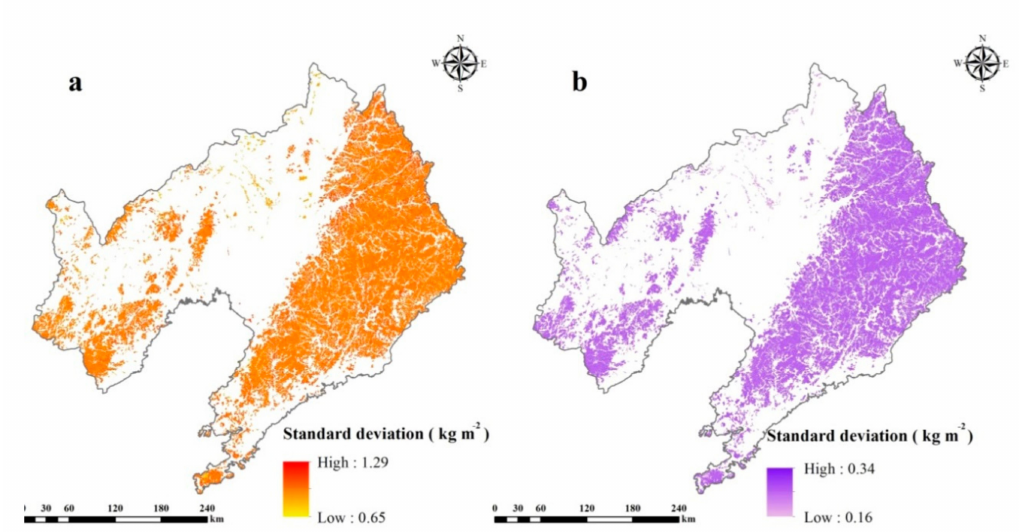
Figure 5. Standard deviation of topsoil (0–30 cm) SOC stocks ( a ) and STN stocks ( b ) predicted by the boosted regression trees (BRT) model.